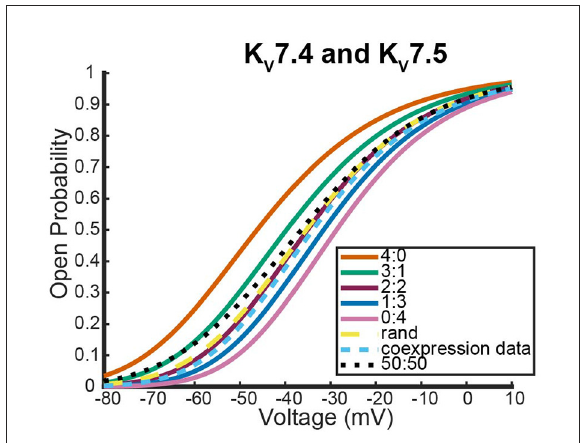
FIGURE9 Steady state probability curves as a function of voltage for cells containing various channel types. The coexpression data and homomeric data for model fitting was taken from Miceli et al. (2015). The steady state probability curves presented here are for homomeric K v 7.2 (4:0) and K v 7.3 (0:4) channels, heteromeric K v 7.2 / 7.3 channels (3:1, 2:2,1:3), the model output of a random assembly of K v 7.2 and K v 7.3 subunits expressed in 50:50 ratio (rand), the data output of a 50:50 expression of K v 7.2 and K v 7.3 subunits (coexpression data), and a model output of an equal split between only homomeric channels (50:50). Curve color and type are shown in the legend. Homomeric channels and their related heteromers being looked at are also detailed in figure title.